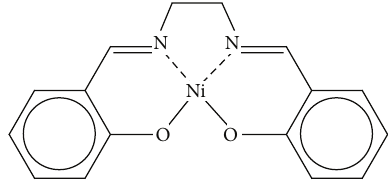
Figure 1: Structure of Ni(II)-salen complex.